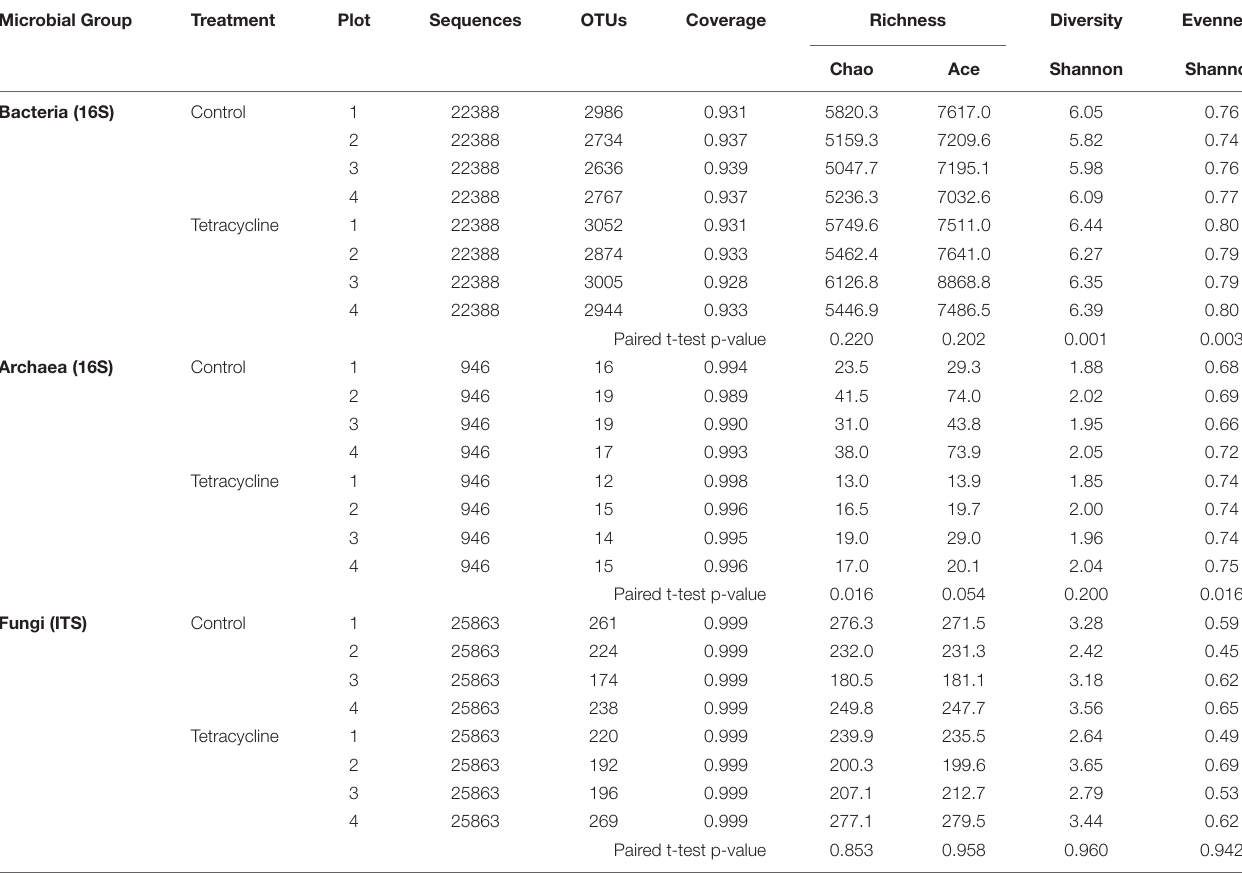
TABLE 2 | Species richness and α -diversity of microbial communities from control and tetracycline samples. Microbial Group Treatment Plot Sequences OTUs Coverage Richness Diversity Evenness Chao Ace Shannon